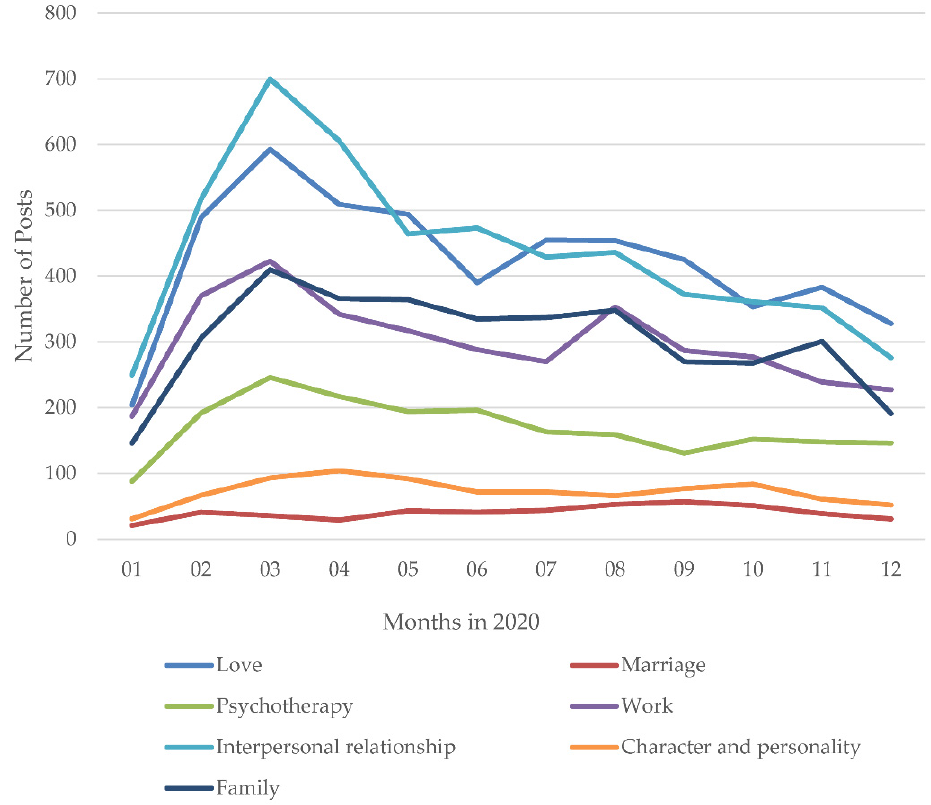
Figure 9. The monthly trends of the number of PHS posts related to influential factors during the COVID-19 pandemic.